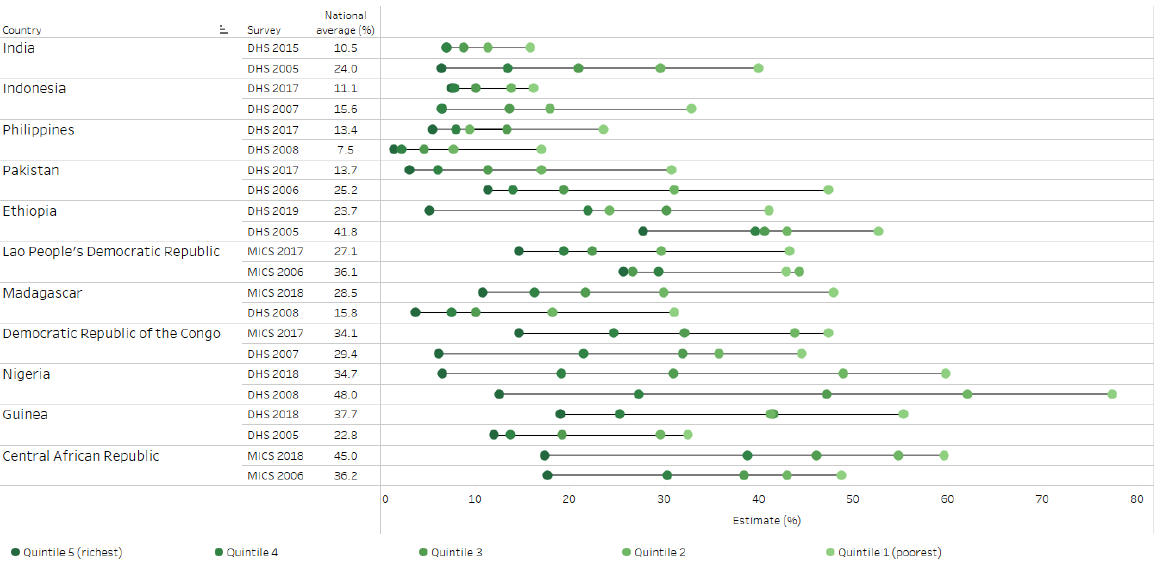
Figure 3. Time trends in percentage of children aged 12 – 23 months who did not receive any doses of DTP-containing vaccine in 11 countries, zero-dose DTP, by wealth quintile. Data taken from DHS and MICS 2000 – 2009 and 2010 – 2019. For each country, disaggregated data are presented for wealth quintiles by colored dots; the horizontal lines indicate the difference between the most extreme quintile values. DHS = Demographic and Health Survey. DTP = diphtheria–tetanus–pertussis vaccine. MICS = Multiple Indicator Cluster Survey.